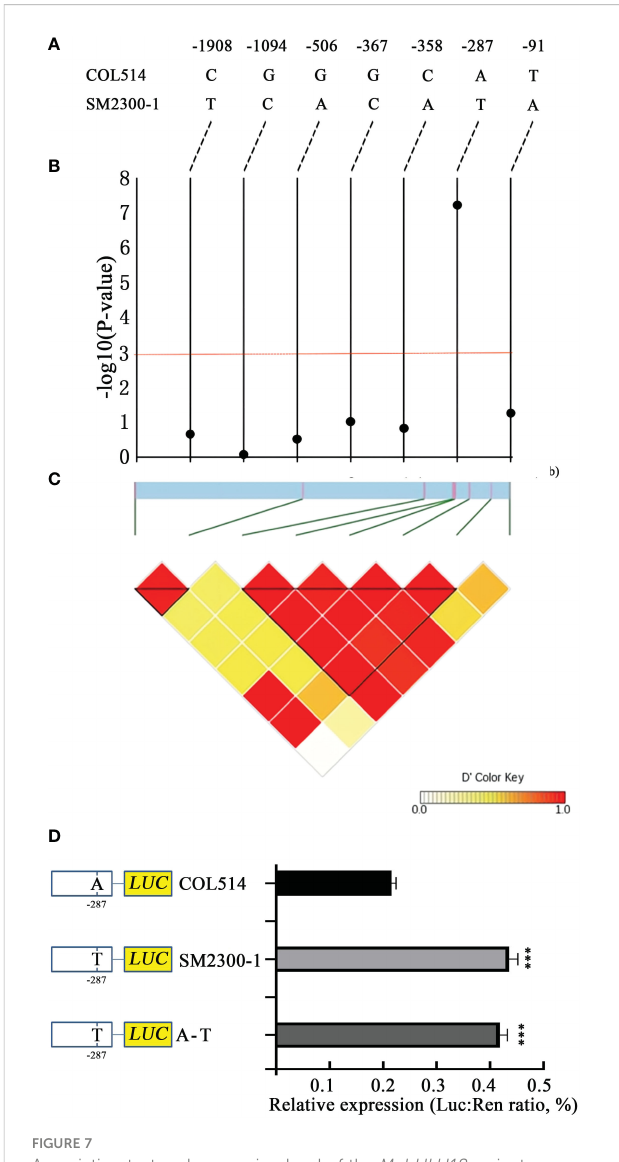
FIGURE 7 Association test and expression level of the MebHLH18 variant. (A) Sequence comparison of the bHLH18 promoter region in cassava germplasm COL514 and SM2300-1. (B) A correlation test of seven variants in the 2.0 kb promoter region with leaf abscission. The black dots represent seven variations. (C) A triangular matrix with a pair of linkage disequilibrium. (D) Transient expression analysis of three single nucleotide polymorphism effects in the MebHLH18 promoter (n=5). The value is represented as mean ± standard deviation. Student t-test was used to generate P-value; ***P <